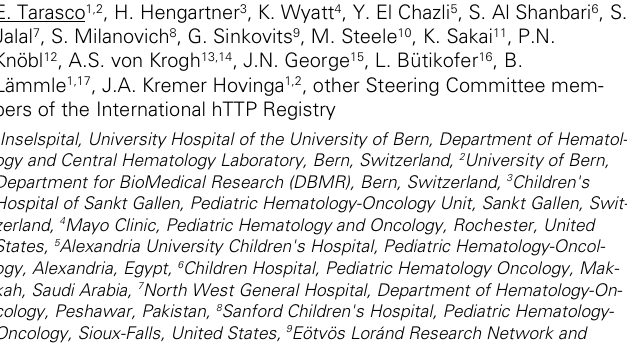
Table: Annual incidence of acute episode during prospective follow-up Sex Age at enrolment Prophylaxis** Overall Male Female 0-6 >6-12 >12-18 Yes** No** No. of patients with follow-up No. of patients with any episo- des No. of prospective episodes